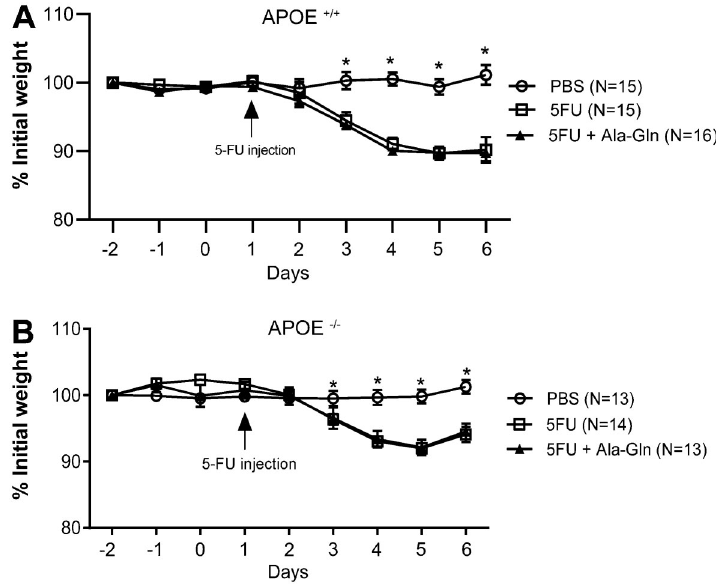
Figure 1. Weight curves of wild-type (APOE +/++ ) ( A ) and APOE knockout (APOE -/- ) mice ( B ) following 5-fluorouracil (5-FU)-induced mucositis and of unchallenged controls receiving phosphate buffered saline (PBS). Data are reported as means±SEM. *P , 0.001 vs other groups (one- way ANOVA, followed by the Bonferroni multiple